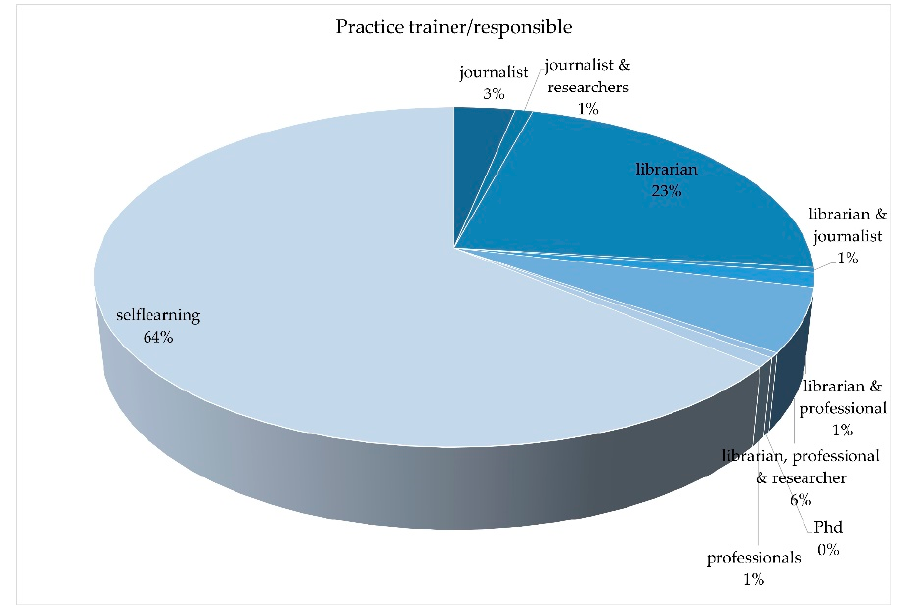
Figure 4. Libraries’ practice trainer or responsible. Source: prepared by the authors.